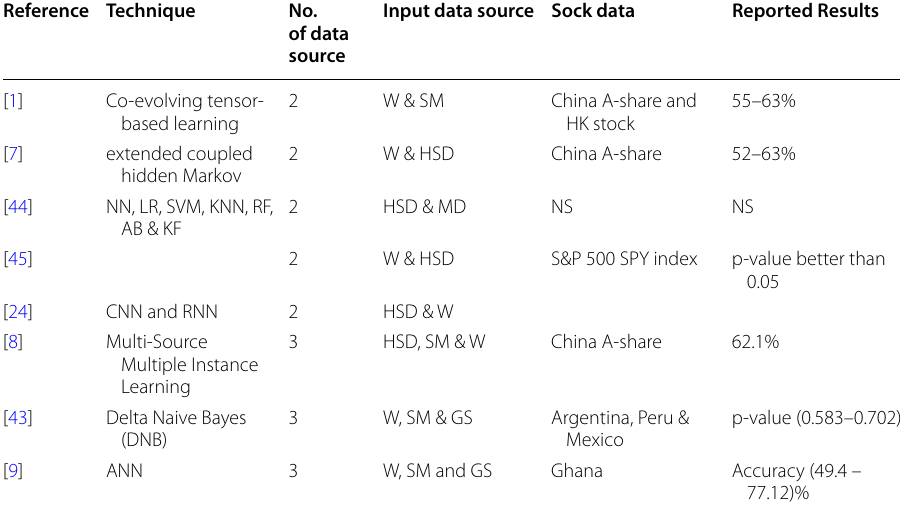
Table 1 A summary of related